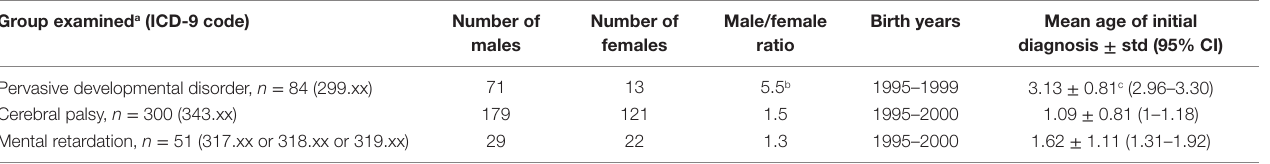
TaBle 1 | a summary of the various types of outcomes examined in the present